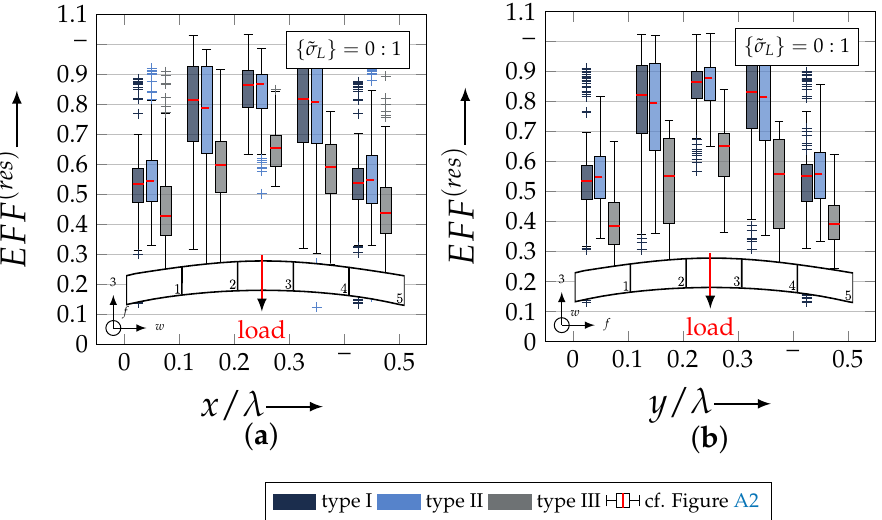
Figure 26. Illustration of the composition of FM by their fractions η the load path { ˜ σ L } = 1:1 for ( a ) weft and ( b ) fill yarn.